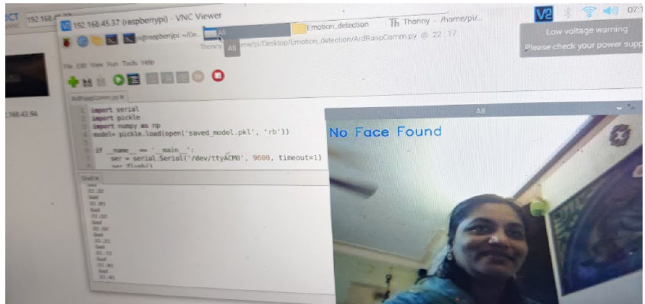
Fig. 11 The bounding box does not appear for face detection so no face detected and no emotion detection on the raspberry pi but the GSR method is working and showing skin conductance with the corresponding label